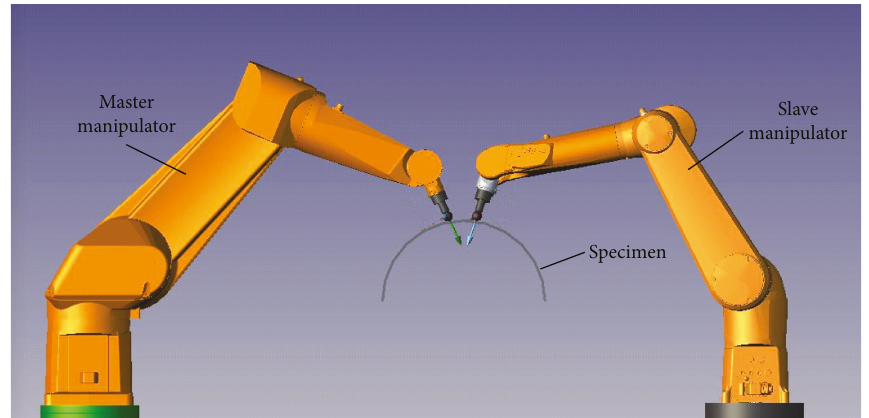
Figure 4: Manipulator distribution.